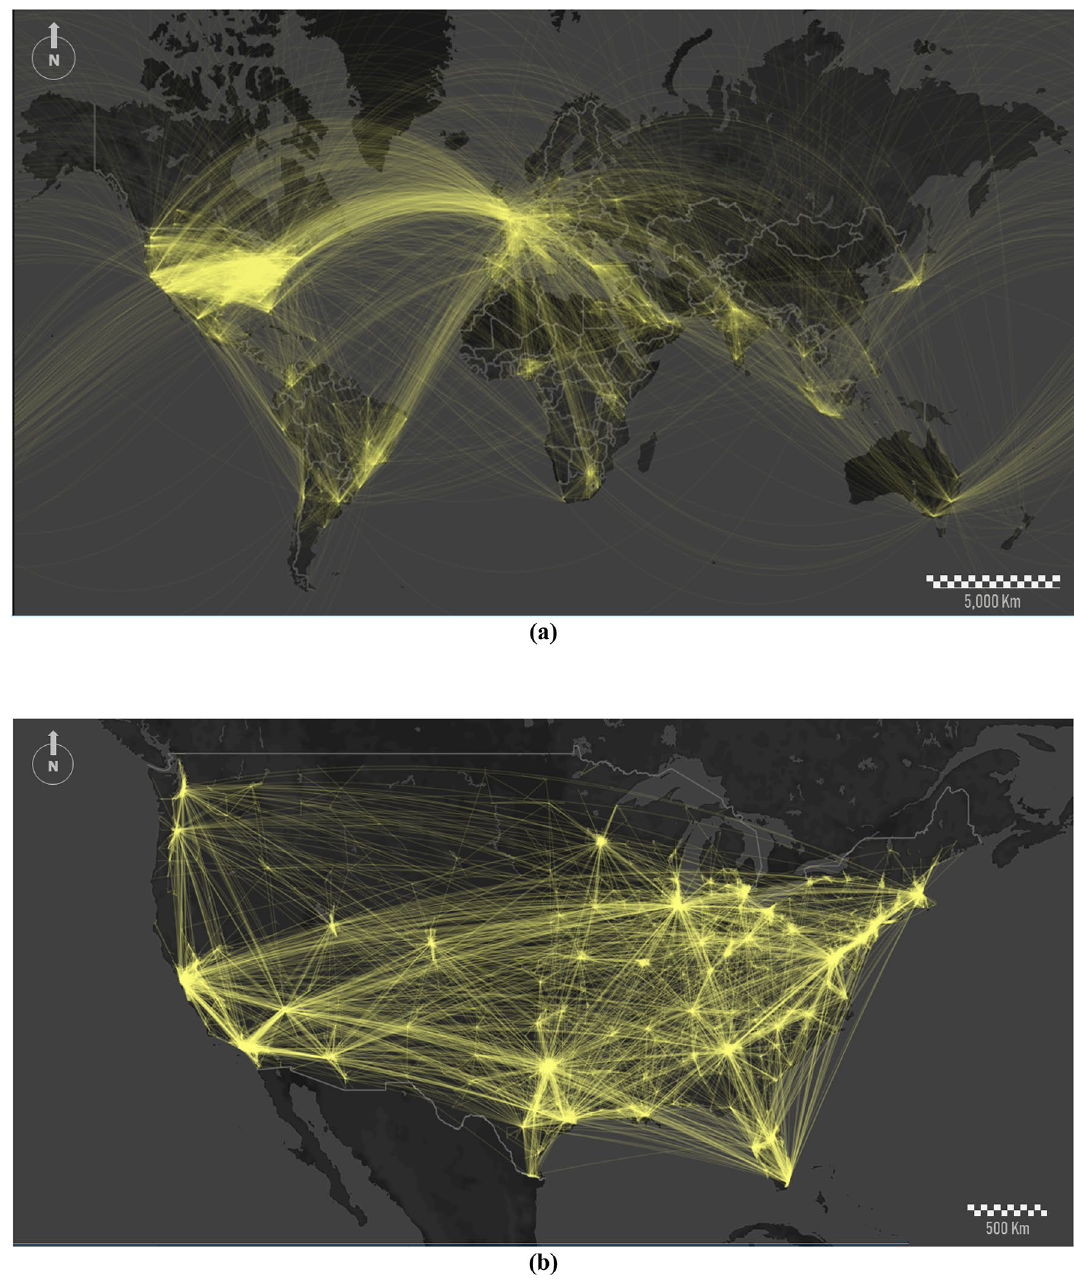
Figure 2. Flows of interconnectivity between users via mentions or retweets: ( a ) global scale, and ( b ) the United States mainland. To make the display clearer, we apply a thinning algorithm for reducing line densities. We reduce the total number of links by 90% in ( a ) and 95% in ( b ). This figure was generated using ArcGIS Desktop and